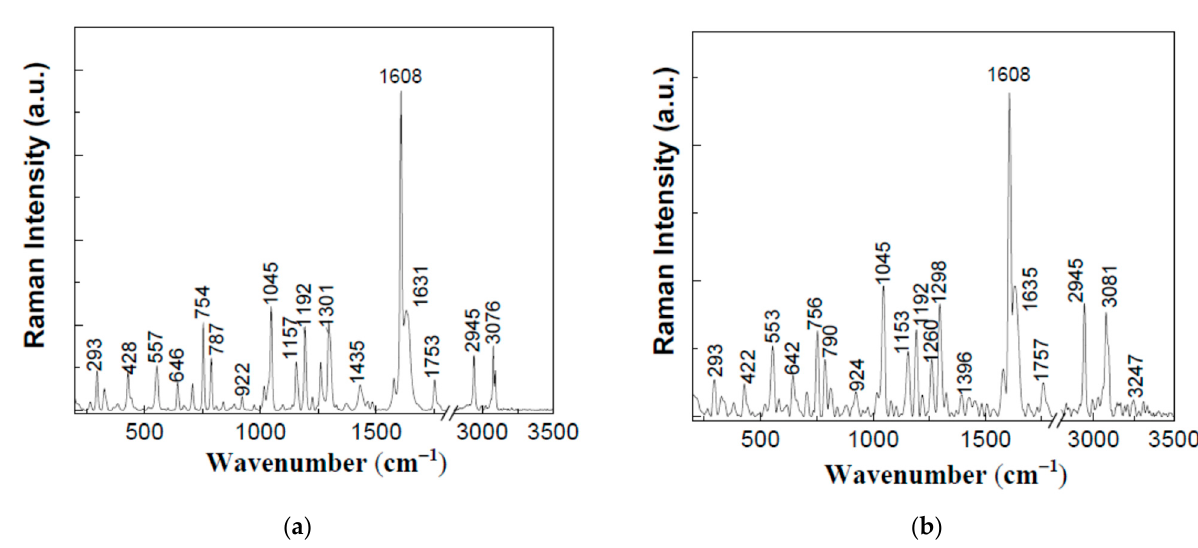
Figure 6. The Raman spectra of ASA in the initial state ( a ) and after the interaction with NaOH ( b ). Additional arguments concerning the interaction of ASA with NaOH are shown in Figure 7.